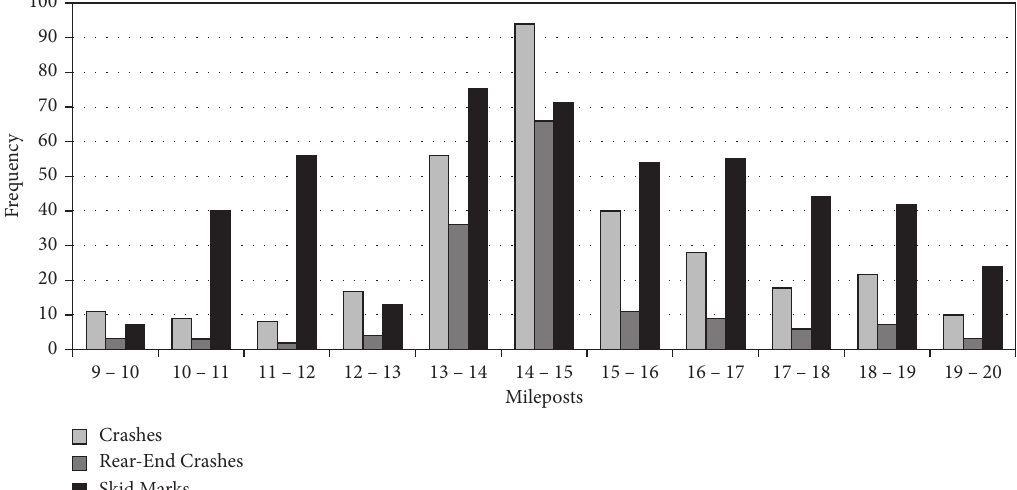
Figure 5: Number of crashes and skid marks on Interstate 80 eastbound.